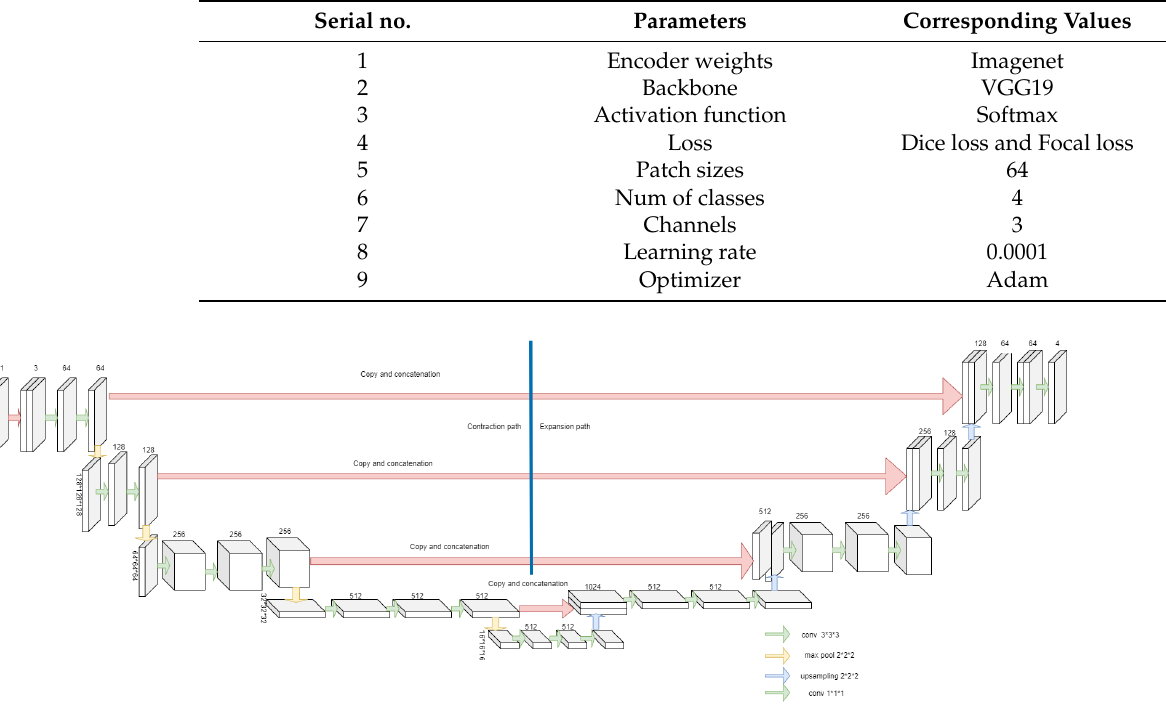
Figure 2. Architecture of our proposed model built combined with VGG19 AND 3D